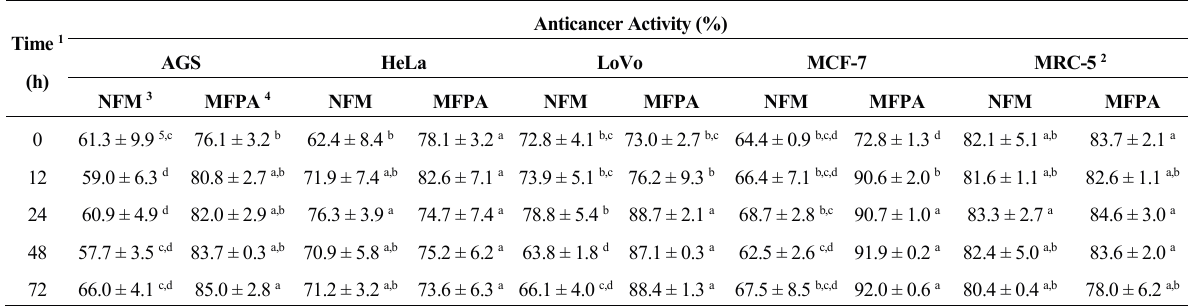
Table 4. Anticanceric effects of fermented M. denudata extract on four different cancer cell